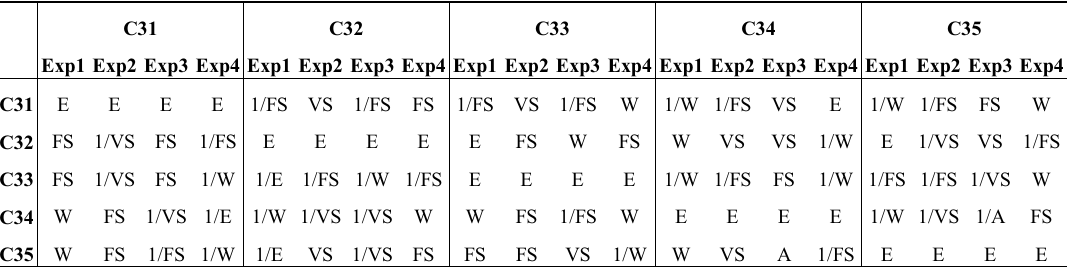
Table 11: Expert Evaluations of sub-criteria (C31-C35) with respect to Partner Firm Related